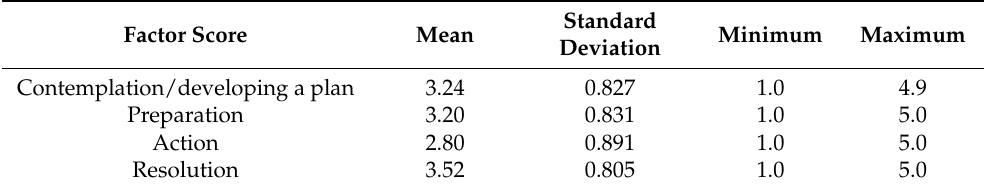
Table 4. Descriptive statistics for the CW factor scores ( n = 242) created as the average of items on a five-point Likert scale. Factor Score Mean